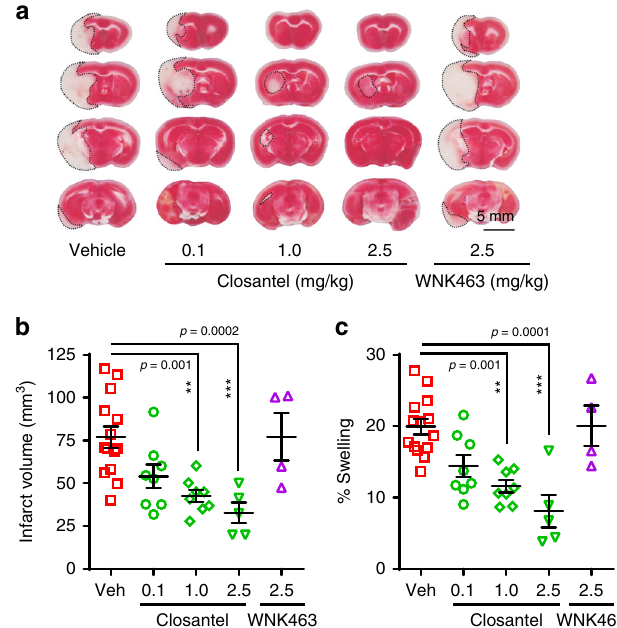
Fig. 9 The SPAK inhibitor Closantel exhibits dose-dependent neuroprotective effects. a Representative images of TTC-stained coronal sections of mouse brain 24h post tMCAO. Vehicle (Veh) control (DMSO, 2ml/kg), Closantel (0.1, 1.0, or 2.5mg/kg), or WNK463 (2.5mg/kg body weight) were administered i.p. in divided doses at 3 and 8 h post reperfusion after tMCAO. b, c Quantitative analysis of mean infarct volume and mean % hemispheric swelling of mouse brains 24h post tMCAO. Data are means± SEM, male mice, n = 14 (vehicle), 8 (Closantel 0.1), 8 (Closantel 1.0), 5 (Closantel 2.5), and 4 (WNK463 2.5). *** p < 0.001 and ** p < 0.01 versus vehicle control, one-way